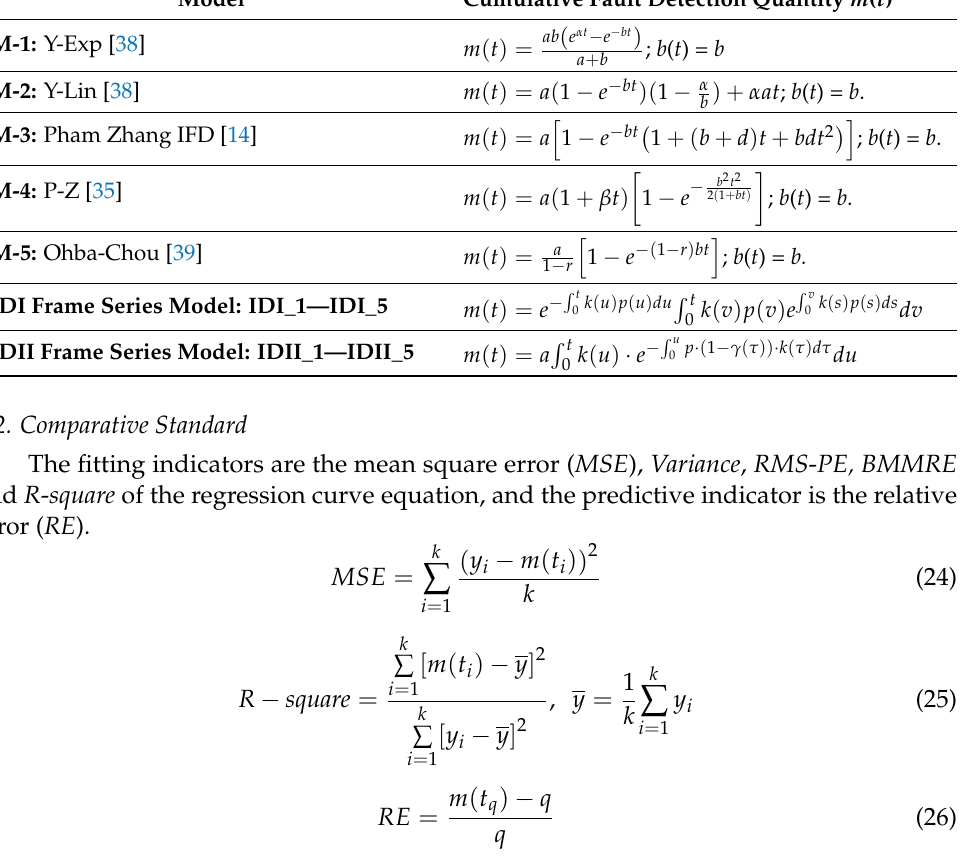
Table 1. Participating models.